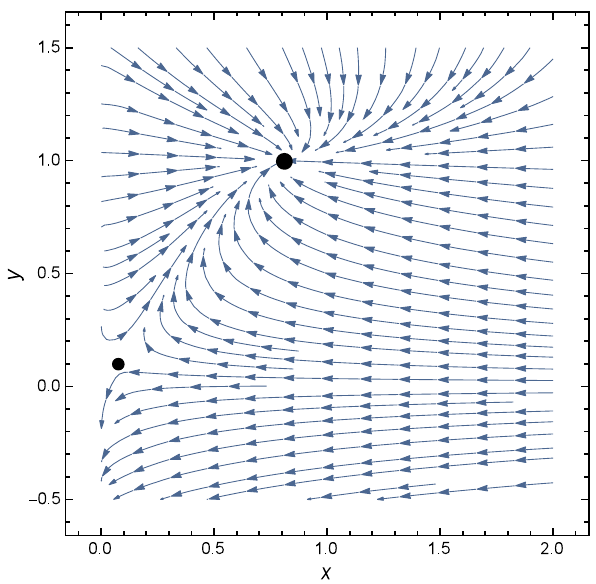
Fig. 1 The larger black point represents the stable point, and the smaller one represents the saddle point